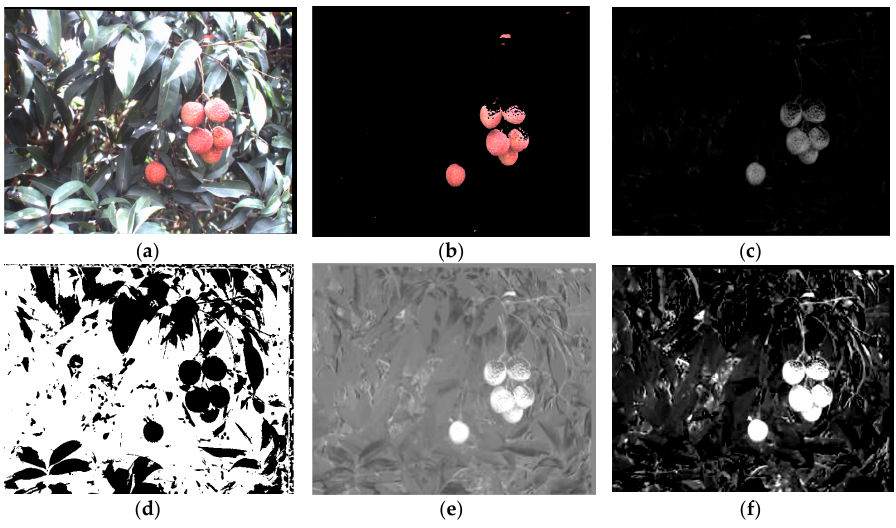
Figure 4. Analysis images of effective color components. ( a ) Original litchi color image; ( b ) Mature litchi fruit extraction based on only red color component; ( c ) R-B component image; ( d ) I component image; ( e ) Cb component image; and ( f ) b* component image.